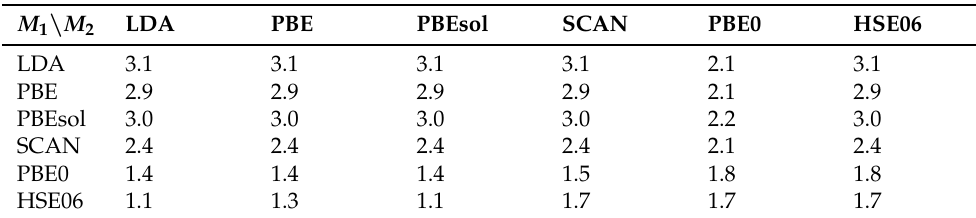
Table 1. Q 95 ( M 1 ) , in eV, for the method indicated by the row ( M 1 ), when similar to the method